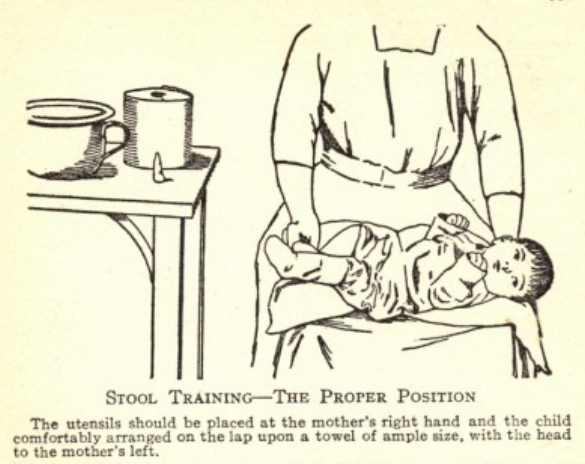
Figure 15. The First Step in Early Bowel Training. None of the illustrations (uncredited) in Richardson’s book show the mother’s head.